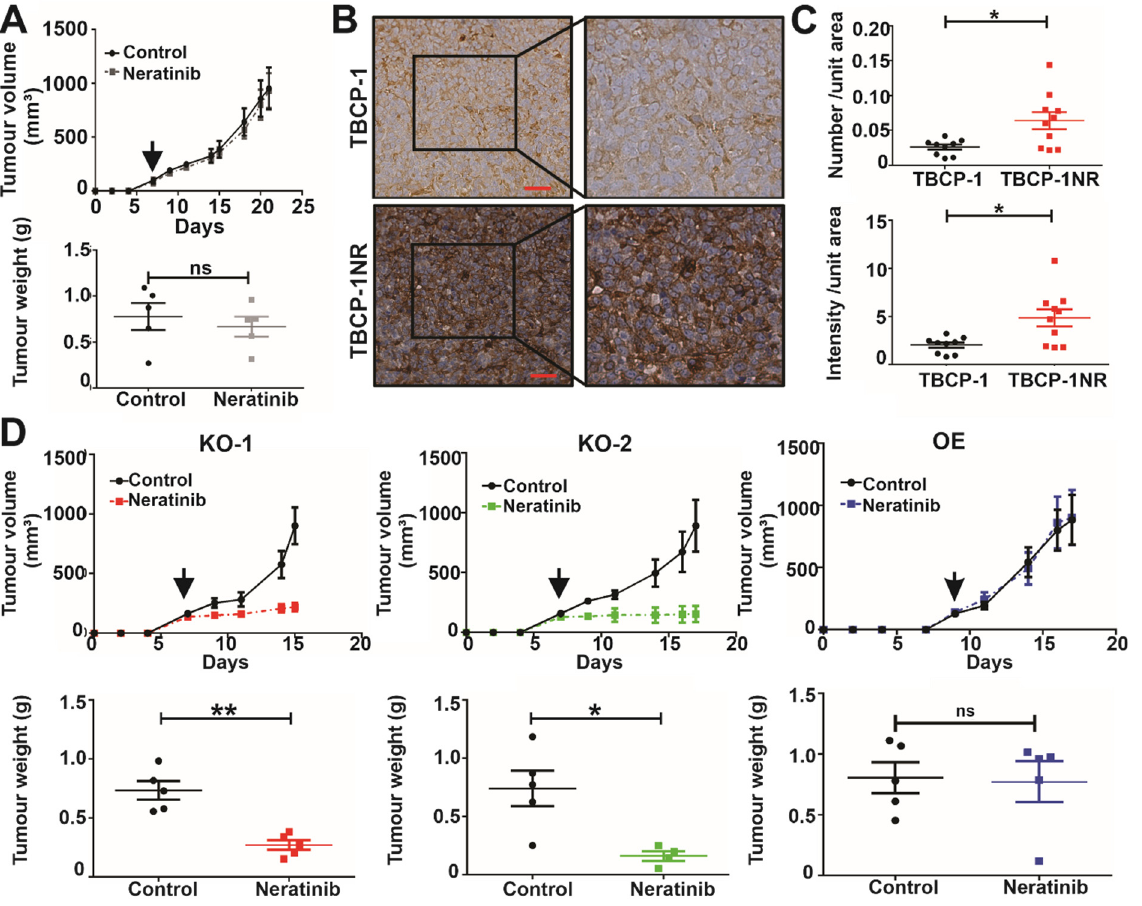
Figure 6. Integrin β 3 regulates neratinib sensitivity in vivo. ( A ) Mice bearing orthotopic TBCP-1NR tumours were treated with vehicle control ( n = 5) or neratinib (60 mg/kg, n = 5) daily by oral gavage starting when tumours reached 100 mm 3 (indicated by an arrow). Data show mean tumour volume of control or neratinib (60 mg/kg) treated mice ± SEM (top panel) and mean tumour weights ± SEM at endpoint (bottom panel). Statistical significance was determined using an unpaired t -test, p < 0.05 was considered significant. ns = not significant. ( B ) Expression of integrin β 3 was analysed in TBCP-1 ( n = 9) and TBCP-1NR ( n = 10) primary tumours using standard IHC. The figure shows representative images of stained TBCP-1 or TBCP-1NR primary tumours. Red (Scale bar) = 50 µm. ( C ) The expression of integrin β 3 was quantitated on Aperio scanned slides using the positive pixel macro in Imagescope software. Data show mean number (top panel) and intensity (bottom panel) of strong positive pixels per unit area ± SEM. Statistical significance was determined using Mann–Whitney t -test, p < 0.05 considered significant, * p < 0.05. ( D ) Mice bearing orthotopic integrin β 3 KO TBCP-1NR tumours (clone KO-1, clone KO-2 or clone KO-1+ integrin β 3 OE) were treated with vehicle control or neratinib (60 mg/kg) daily by oral gavage starting when tumours reached 100 mm 3 (indicated by an arrow). Data show reduced tumour growth rate after neratinib treatment in KO-1 or KO-2 tumours but not in KO-1 tumours with forced integrin β 3 OE (top panel). These trends were also represented in the primary tumour weights measured at endpoint. Data (bottom panel) show mean weight ± SEM. Statistical significance was determined using Mann–Whitney t -test, p < 0.05 was considered significant, * p < 0.05, ** p < 0.01, ns = not significant.